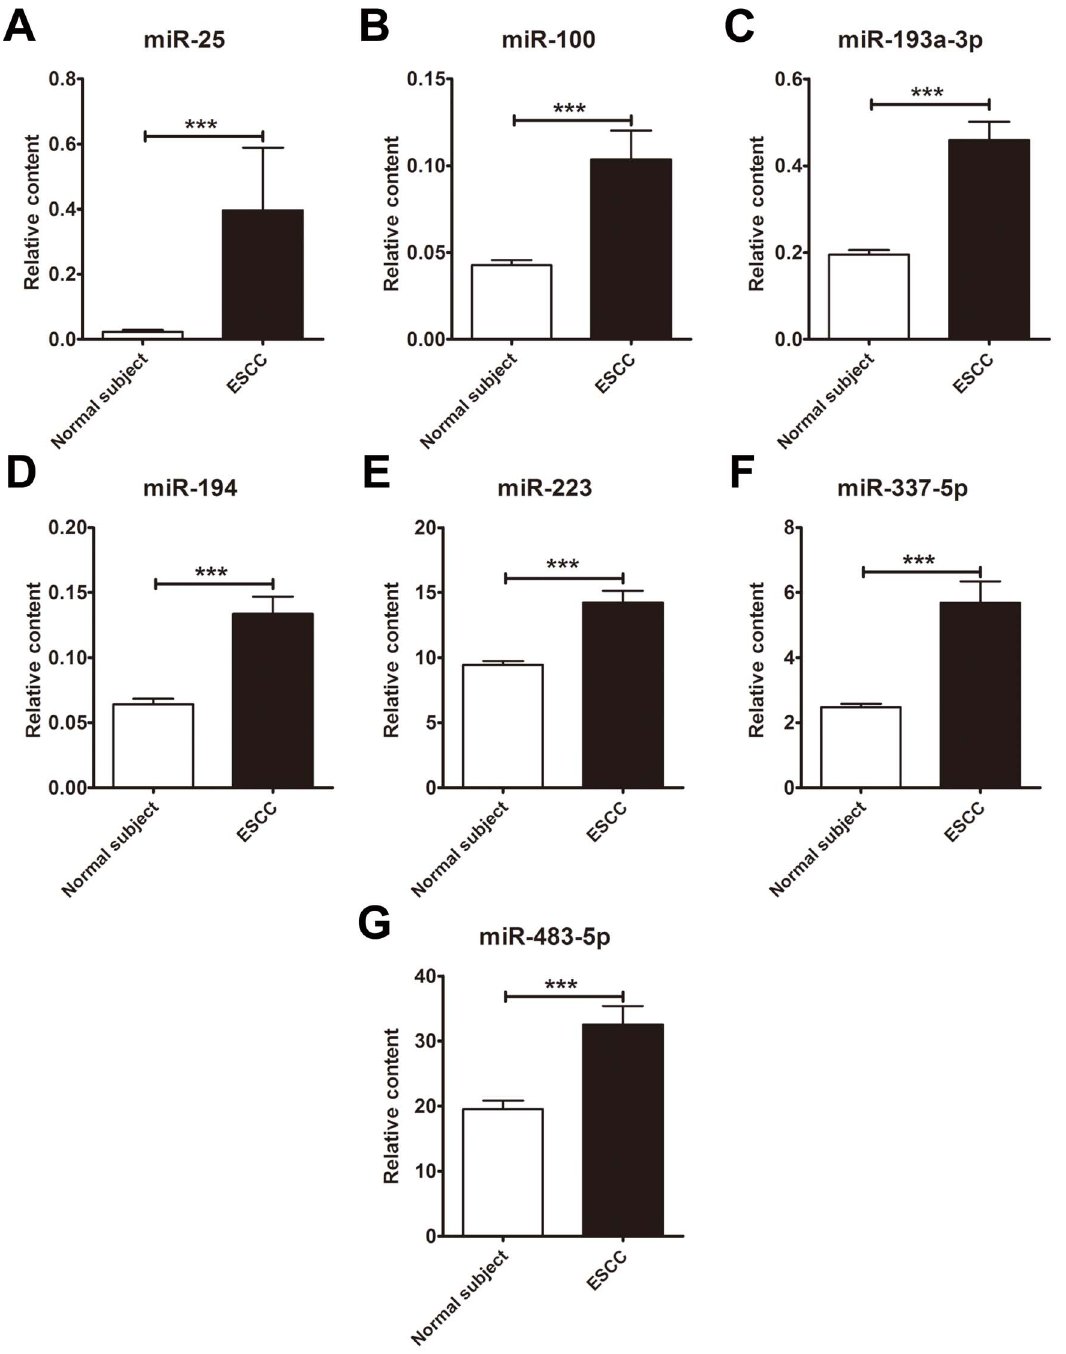
Figure 2. The significantly elevated miRNAs in sera from patients with oesophageal squamous cell carcinoma (ESCC). (A–G) The contents of seven miRNAs including miR-25, miR-100, miR-193-3p, miR-194, miR-223, miR-337-5p and miR-483-5p were validated in sera from ESCC patients (n=63) and normal subjects (n=63) by RT-qPCR assay. The relative levels of the seven miRNAs were normalized to let-7d/g/i and calculated using the 2 2 DD Cq method. Error bars = SEM. Asterisks refer to P ,